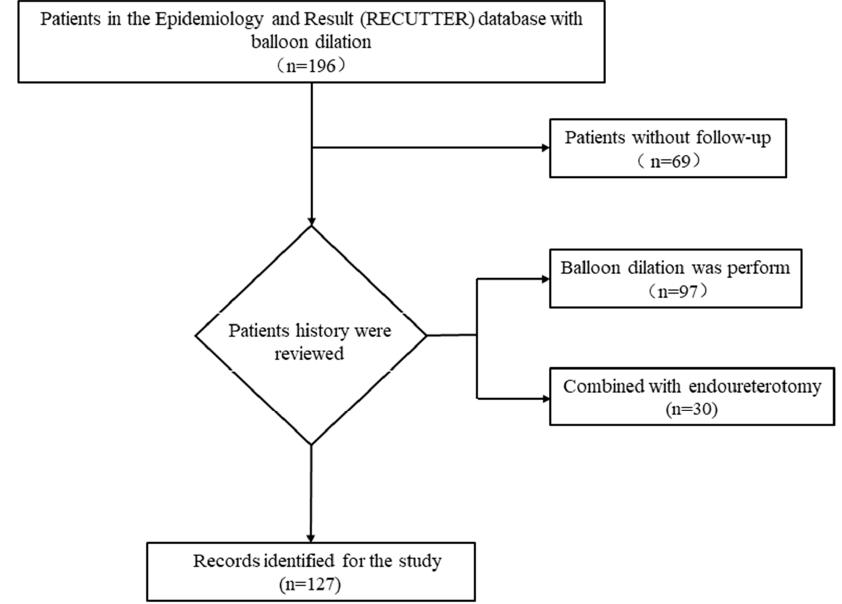
Figure 1. Flow chart of inclusion and exclusion criteria of the study. Table 1. Patient characteristics.